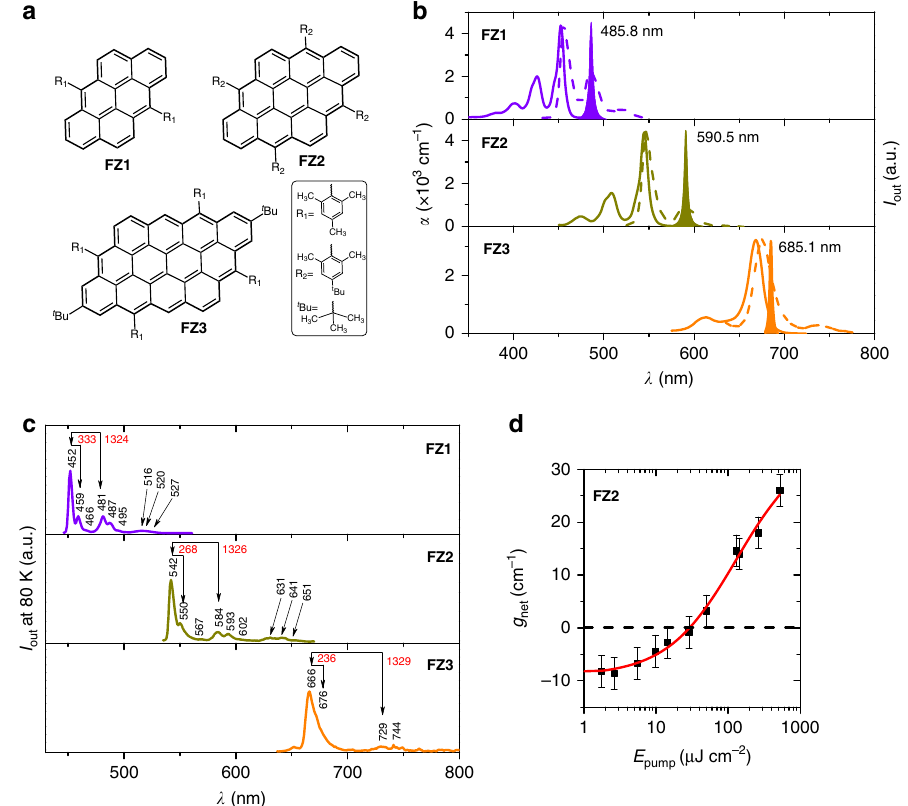
Fig. 1 Chemical structures of nanographenes and their optical properties dispersed in polystyrene fi lms. a Chemical structures of nanographenes FZ1, FZ2, and FZ3, respectively. b Optical properties at room temperature of PS fi lms doped with 1 wt% of FZ1, FZ2, and FZ3, from top to down. Absorption coef fi cient, α (solid line, left axis), photoluminescence intensity (dashed line, right axis), and ampli fi ed spontaneous emission, ASE, intensity ( fi lled area, right axis), versus wavelength, λ . c Low temperature (80 K) PL spectra of the three nanographenes in methyl tetrahydrofurane (methyl THF) solution. The wavelengths of each peak, and the spacing (in red, in cm − 1 ) for each vibrational progression are indicated. d Net gain coef fi cients, g net , obtained from plots such as those of Supplementary Fig. 3, versus the pump energy density, E pump , for a 1 wt% FZ2-doped PS fi lm. The full line is a guide to the eye and its intersection with the y- axis corresponds to the loss coef fi cient ( k = 9 ± 1 cm − 1 ). Errors in g net were estimated statistically as the standard deviation from measurements on several nominally identical samples. Source data are provided as a Source Data fi le in the Institutional Repository of the University of Alicante [http://hdl.handle.net/10045/92007] Table 1 Optical properties of FZ nanographene compounds dispersed in PS fi lms (no resonator) FZ compound a